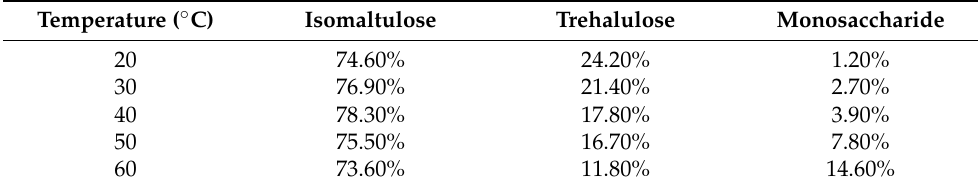
Figure 3. Characterization of Pal-2. Values are the means of three replicates ± the standard deviation. ( a ) The effect of temperature on the activity of recombinant Pal-2. ( b ) Thermostability of recombinant Pal-2 at different temperatures: 45 ◦ C (•) and 50 ◦ C ( (cid:4) ). ( c ) The effect of pH on the activity of recombinant Pal-2. ( d ) pH stability of recombinant Pal-2. ( e ) The effect of metal ions and other reagents on the activity of recombinant Pal-2. ( f ) Lineweaver–Burk plot of purified recombinant Pal-2 using sucrose as a substrate. Table 3. Effect of temperature on product ratio.